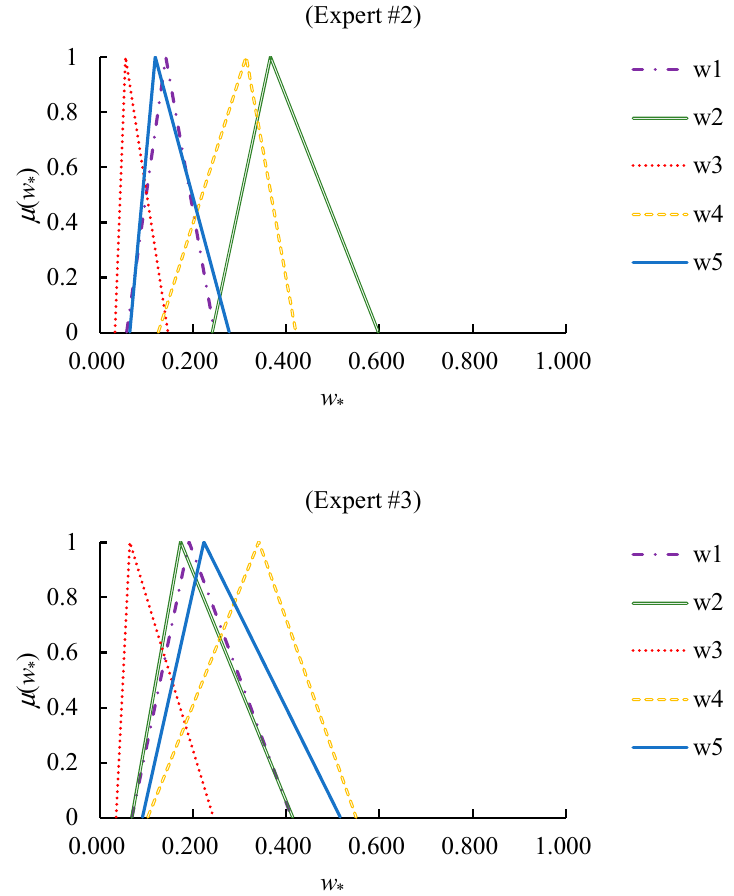
Figure 9. The values of fuzzy priorities in scenario II. Among the five criteria, “level of buyer–supplier cooperation” and “company repu- tation” were the-higher-the-better criteria, whereas the others were the-lower-the-better criteria. The performances in optimizing these criteria were evaluated according to the rules depicted in Table 4, based on the formulae proposed by [37,43]. Table 4. Rules for evaluating the performances in optimizing critical factors.